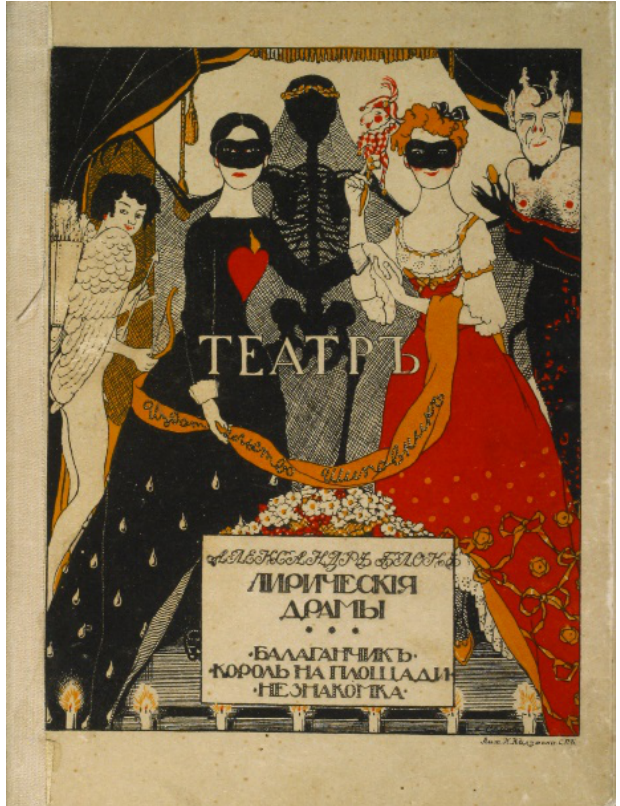
Figure 3. A. Blok. Lyrical Dramas… Sankt-Peterburg, 1908. Cover by K.A. Somov.